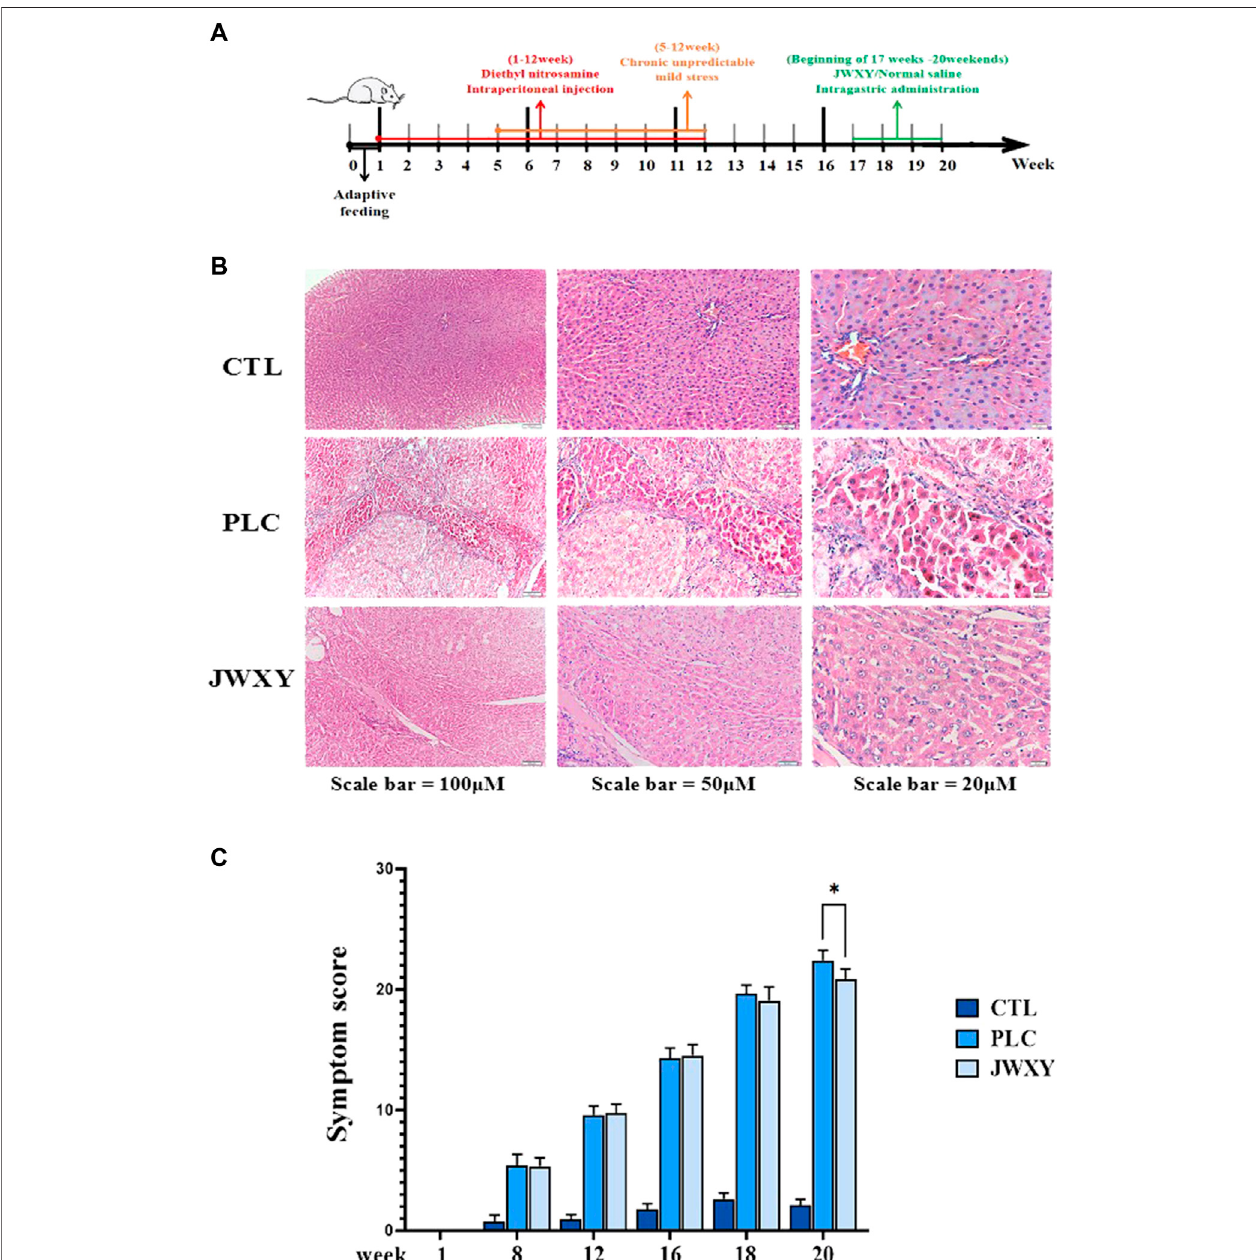
FIGURE 1 | (A) : Process diagram of liver cancer model of liver depression and spleen de fi ciency. (B) Liver HE staining of CTL, PLC, and JWXY groups at different magni fi cations(bar=100/50/20 μ M). (C) Symptomscoreofthethreegroupswas0inthe fi rstweek,andthesymptomscoreofPLCandJWXYgroupswassigni fi cantly higherthanthatoftheCTLgroupintheeighthweek.ThesymptomscoreoftheJWXYgroupwaslowerthanthatofthePLCgroupinthe18thweekandwassigni fi cantly lower than that of the PLC group in the 20th week ( p < 0.05).